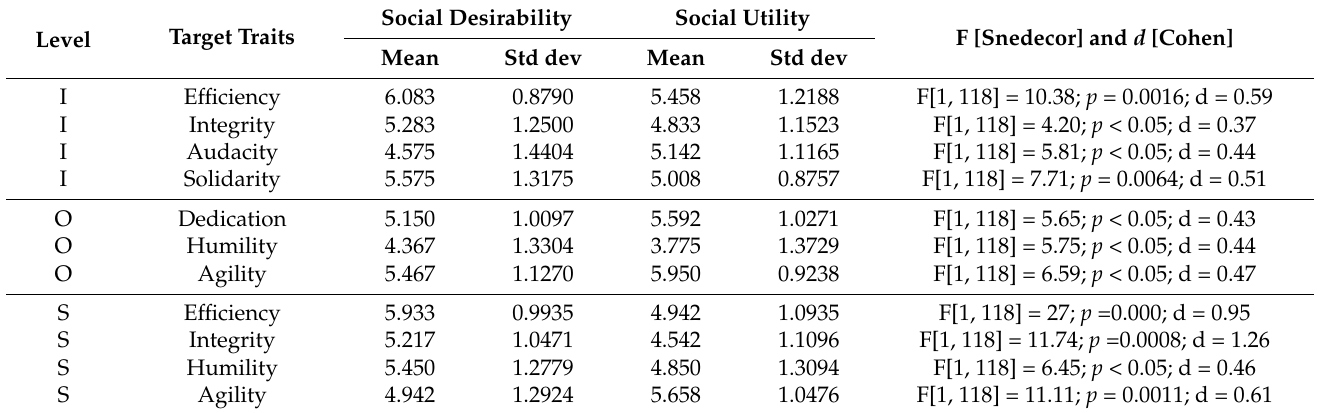
Table 3. Means and effects of the type of judgments (desirability and utility), differentiated according to the individual, organisational and societal